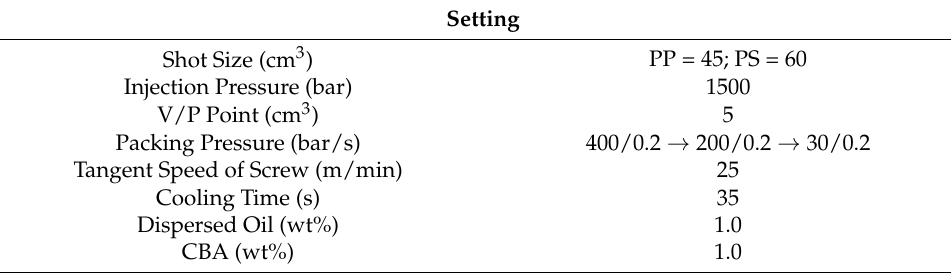
Table 3. Other fixed